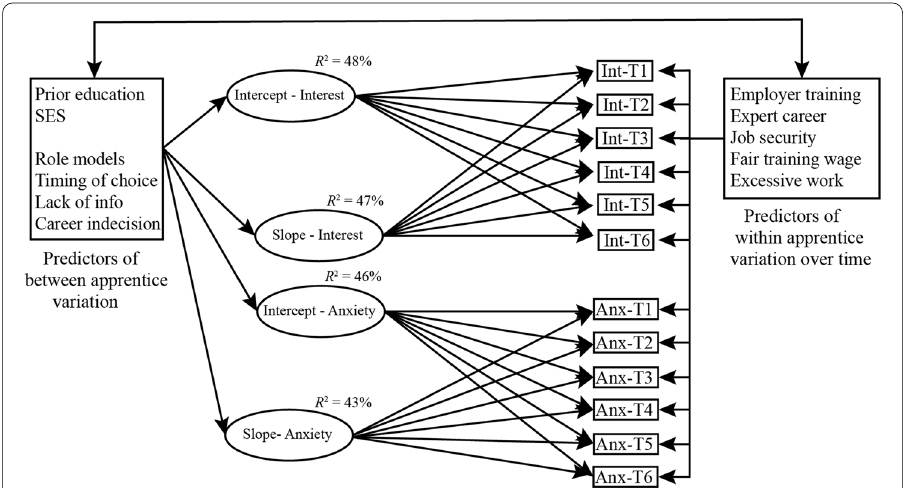
Fig. 3 Conditional LGM with time-varying and time-invariant predictors. Int interest, Anx anxiety. Covariances across latent variables, and observed variables at same timepoint excluded for